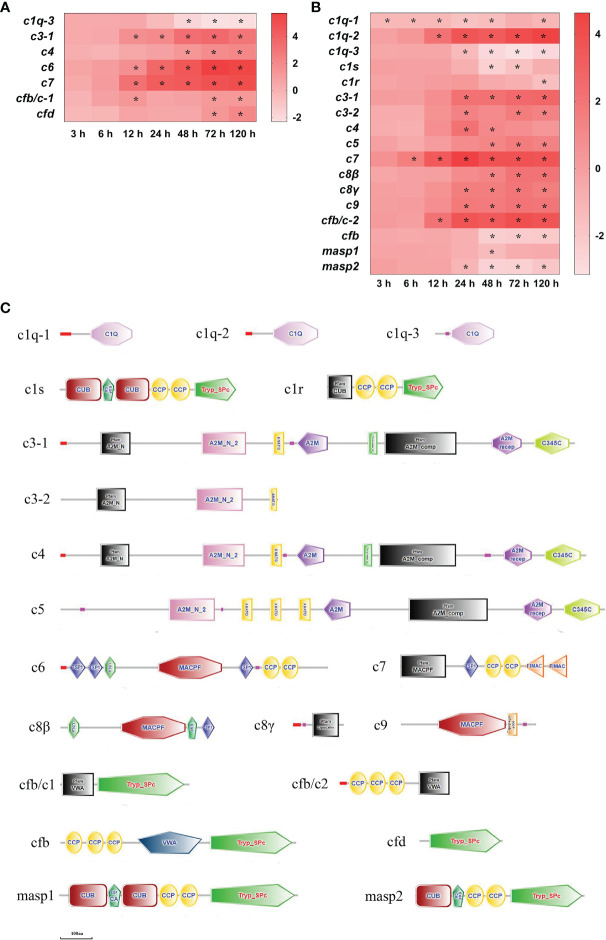
The DEGs of complement in yellow catfish after E. ictaluri infection. (A, B): The DEGs identified in the spleen and liver, respectively. The DEGs of complement were analyzed at 3 h, 6 h, 12 h, 24 h, 48 h, 72 h, and 120 h post-infection in the spleen and liver. The color gradient represents highly up-regulated (red) to highly down-regulated (white) genes. Significant differences at different time points post-infection compared to the control (0 h) are indicated by asterisks (*P < 0.05). (C): Structural features of complement DEGs in yellow catfish. The domain organizations were predicted by the SMART online server.